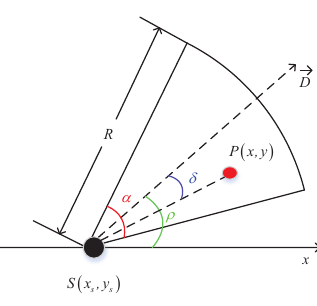
Figure 2. Directional sensor